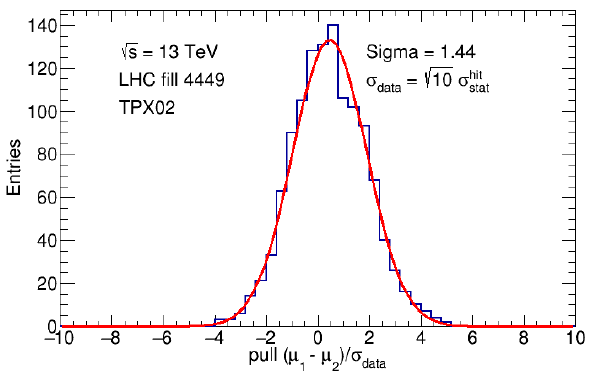
√ R · σ hit , with R = N hit / stat